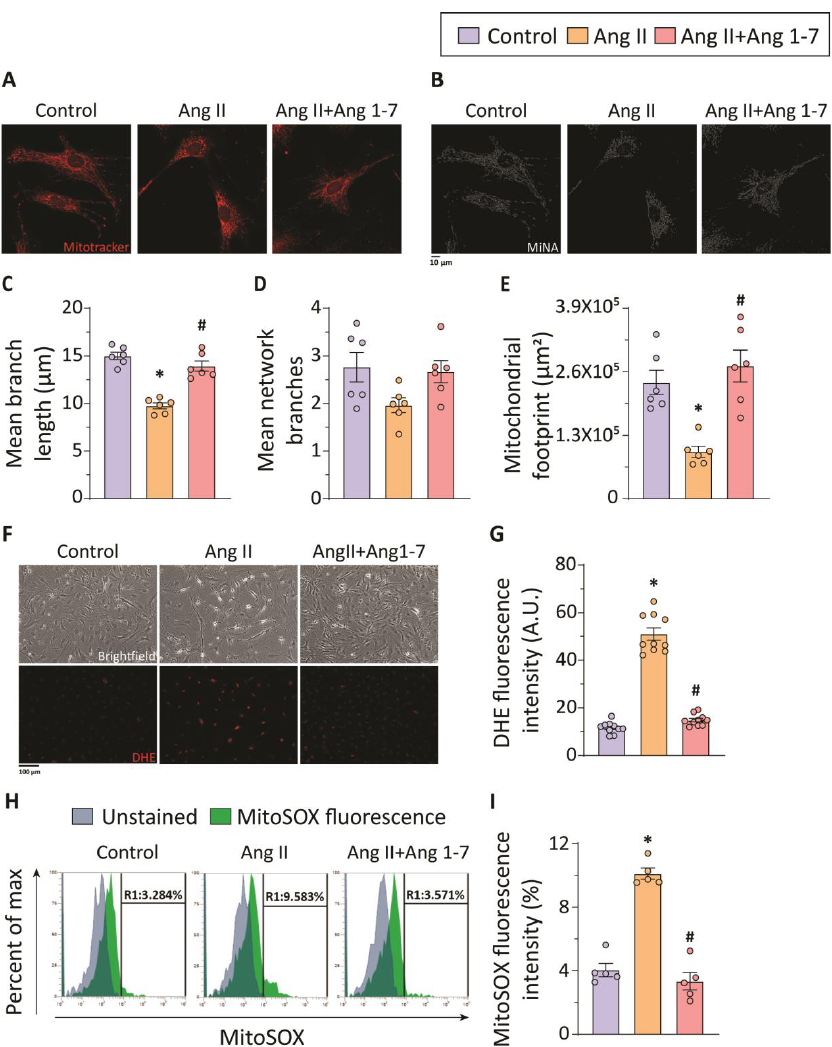
Figure 5. Ang 1-7 attenuates Ang II-mediated mitochondrial fission and ROS generation in tho- racic aortic SMCs. Representative confocal images of Mitotracker red staining ( A ) and their analysis using the Mitochondrial Network Analysis program (MiNA plugin; ImageJ; ( B )) show smaller and more fragmented mitochondria in response to Ang II-treated thoracic aortic SMCs compared to the control group (n = 6 in each group). Quantification of Mitotracker red-staining images using MiNA showing decreased mean branch length ( C ), mean network branches ( D ), and decreased mitochondrial footprint ( E ) in Ang II-treated VSMCs compared to control group. Ang 1-7 treatment attenuates Ang II-induced mitochondrial fission ( A – E ). Representative brightfield microscopy and confocal microscopy images of DHE-stained thoracic SMCs ( F ), along with quantification of DHE fluorescence intensity ( G ), show increased cellular ROS levels in Ang II-treated VSMCs compared to the control group (n = 5 in each group). Flow cytometric analysis of MitoSOX-stained thoracic aortic SMCs ( H ) and quantification of MitoSOX fluorescence ( I ) indicate increased mitochondrial ROS levels in Ang II-treated VSMCs (n = 5 in each group). Ang 1-7 treatment mitigates Ang II-mediated increased cellular and mitochondrial ROS levels in thoracic aortic SMCs ( F – I ). A.U.: arbitrary unit; * p < 0.05 compared with the control group; # p < 0.05 compared with Ang II group using one-way